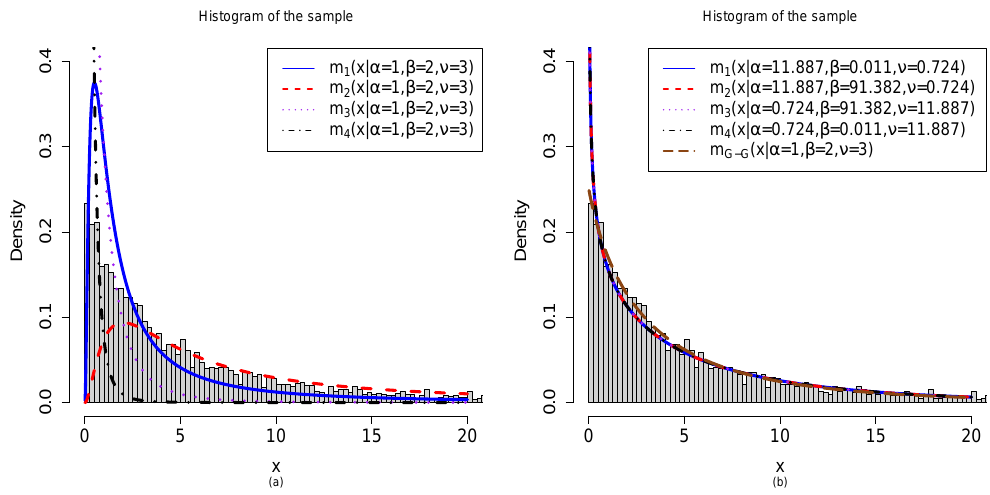
Figure 10. The histogram of the sample with sample size n = 5000 from the hierarchical G ( ν , θ ) − G ( α , β ) model with α = 1, β = 2, and ν = 3 and the fit marginal densities. ( a ) The histogram is fit by m i ( x | α = 1, β = 2, ν = 3 ) , i = 1,2,3,4. ( b ) The histogram is fit by m i 1,2,3,4, where ˆ α i , ˆ β i , and ˆ ν i are the moment estimators of the hyperparameters. Moreover, the histogram is also fit by m G − G ( x | α = 1, β = 2, ν = 3 )